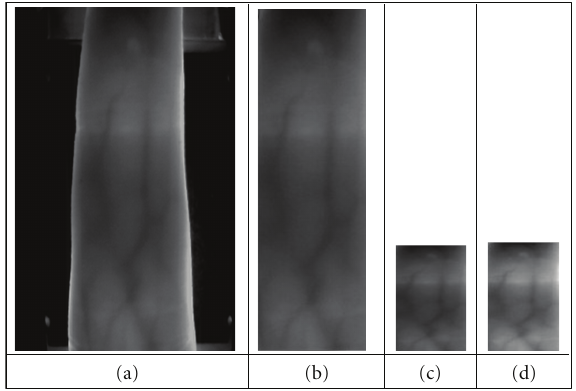
Figure 3: Examples of preprocessing.